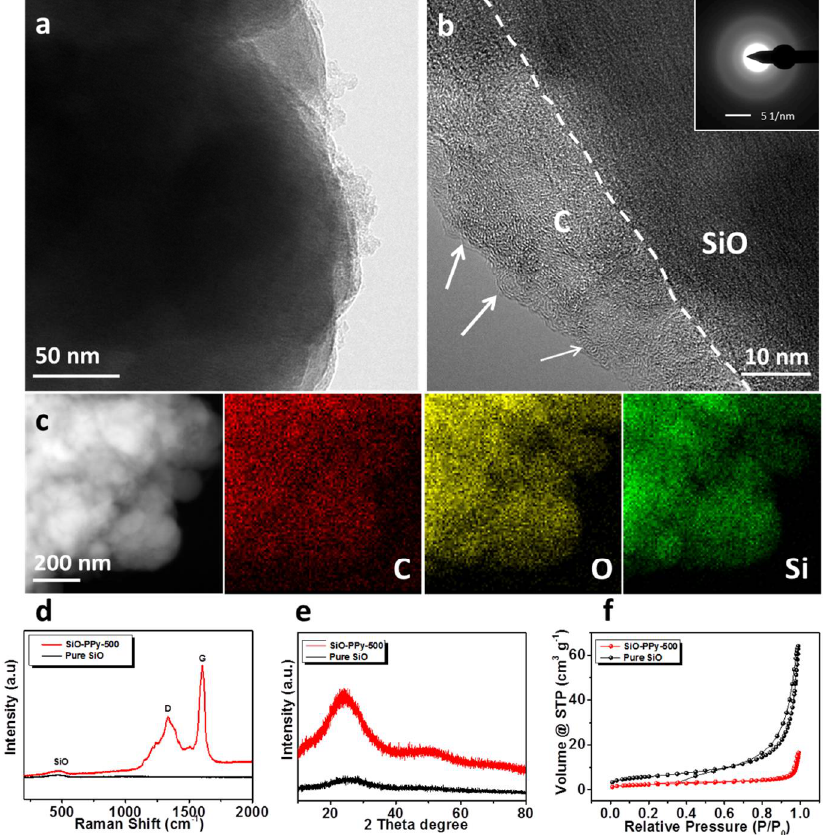
Figure 2. ( a , b ) High-resolution transmission electron microscopy (HRTEM) images of SiO–PPy–500. The top insert is the Selected Area Electron Diffraction (SAED) of the carbon; ( c ) Energy-dispersive X-ray spectroscopy (EDX) mapping of SiO-PPy-500; ( d ) Raman spectra of pure SiO and SiO–PPy–500; ( e ) x-ray diffraction (XRD) spectra of pure SiO and SiO–PPy–500 samples; and ( f ) the adsorption-desorption isotherm of pure SiO and SiO–PPy–500